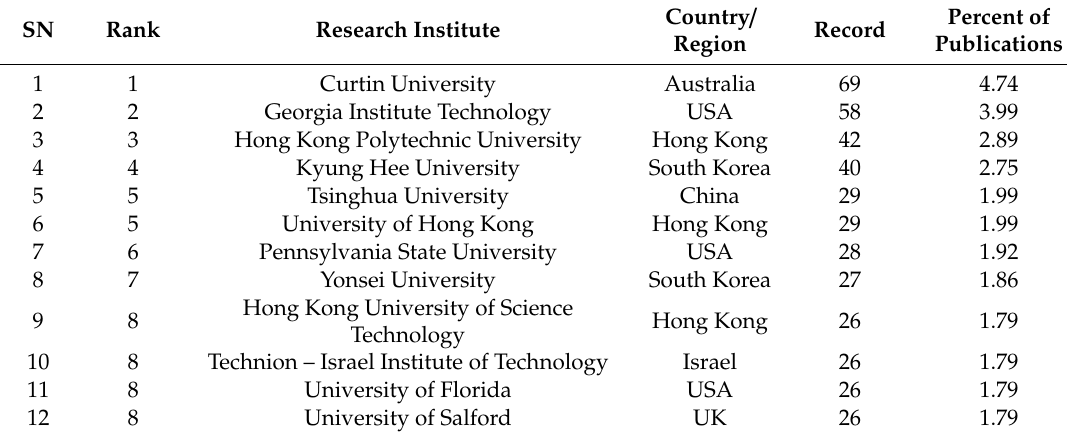
Table 4. Top 10 productive research